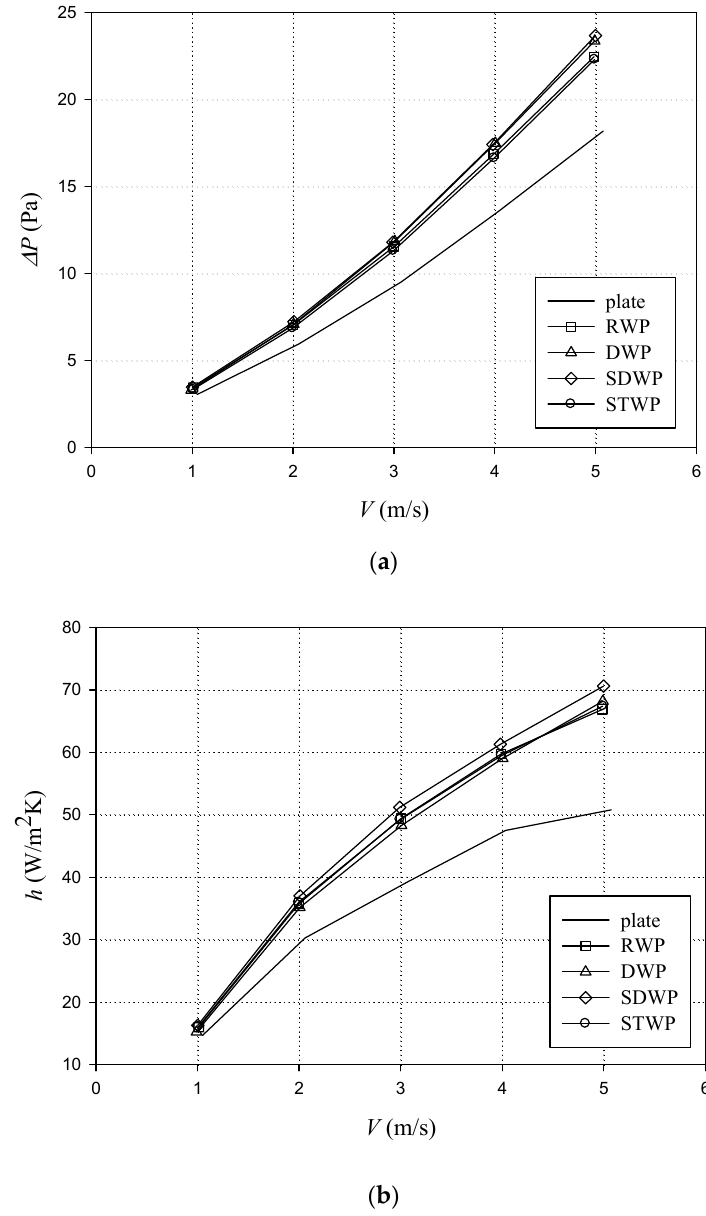
Figure 7. The measured ( a ) pressure drop and ( b ) heat transfer coefficient of the tested heat sinks at a frontal air velocity ranging from 1 m/s to 5 m/s.